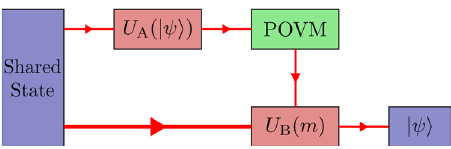
Fig. 4 Pictorial representation of the remote state preparation protocol. Alice performs U A ð ψ j iÞ on her share of a physical system – a unitary operation that depends on ψ j i – and then a measurement (POVM). She sends a classical message m to Bob, who, in turn, performs an unitary transformation (which depends on m ) on his share of the system. The outcome of the protocol is a quantum state on state ψ j i on Bob's